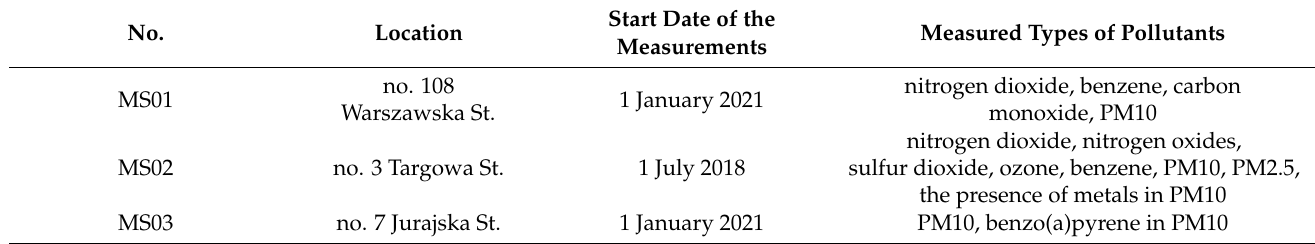
Table 1. Specification of air monitoring stations in Kielce